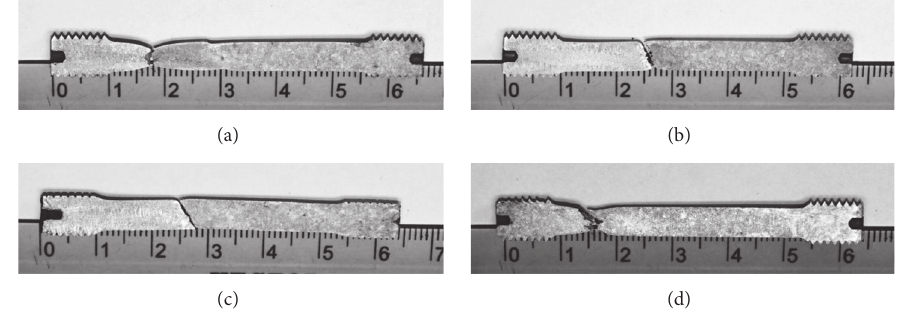
Figure 11: Longitudinal sections of creep specimens counterparts indicating the following: “type I failure” in WM after creep test of CB2 welded joint at 625 ∘ C/120MPa (a), “type III failure” in FZ after creep test at 625 ∘ C/100MPa (b), “type III failure” in FZ after creep test at 625 ∘ C/80MPa (c), and failure in CB2 BM of weld-free specimen after creep test at 625 ∘ C/120MPa (d).